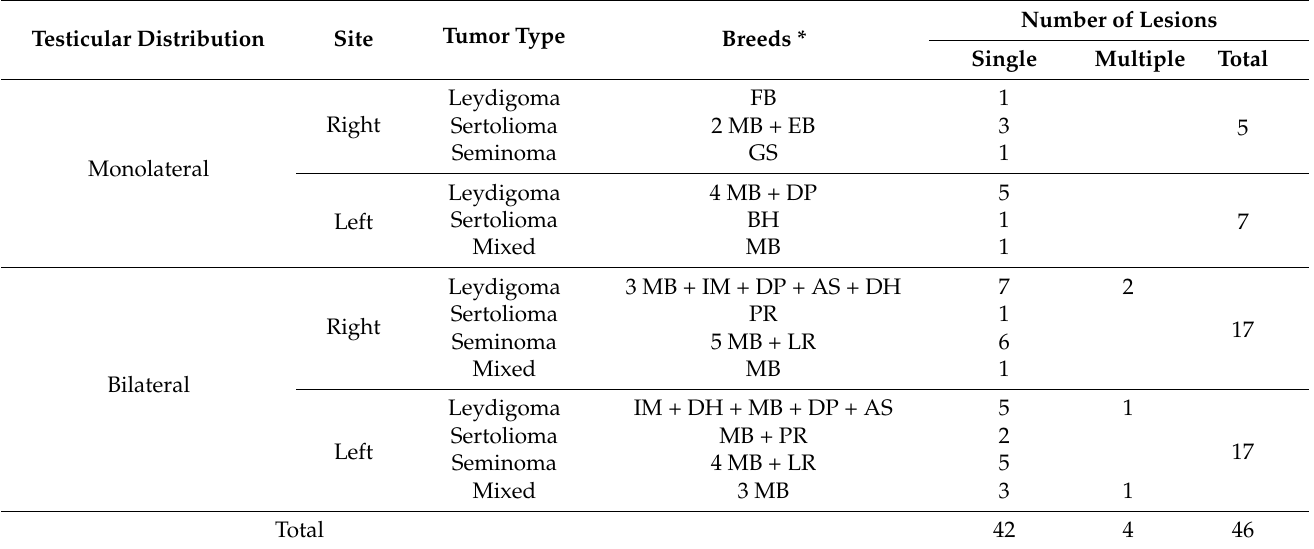
Table 1. Characterization of the 46 testicular tumor lesions detected in 27 dogs of different breeds included in the